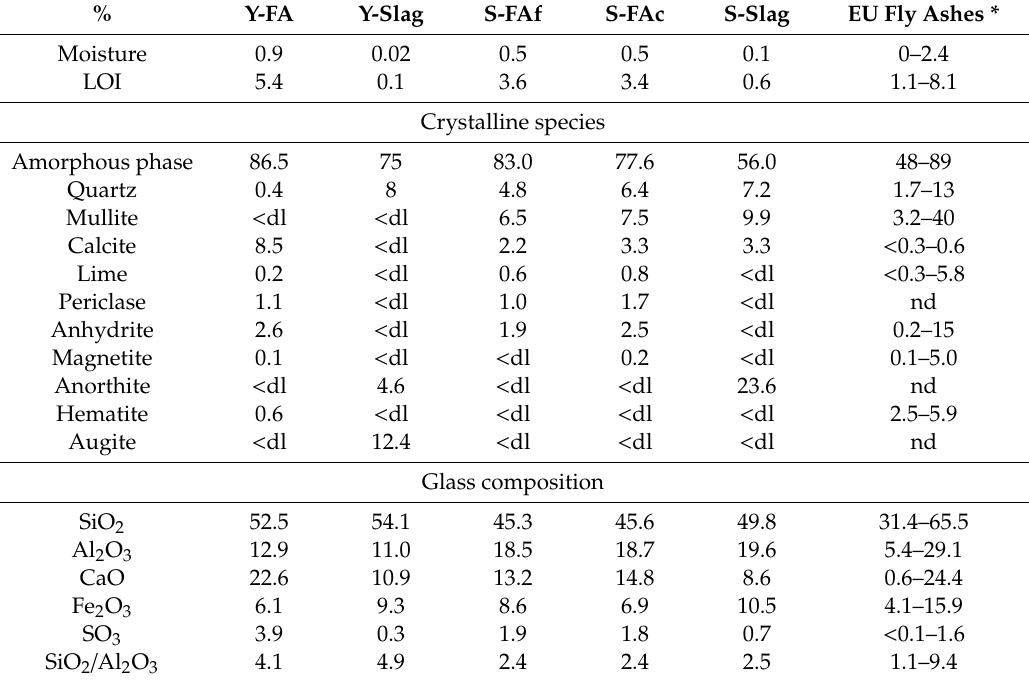
Table 3. Physic-chemical parameters, quantitative analyses of the major crystalline species and glass composition for fly ash and slag samples from Shenhuo and Yihua power